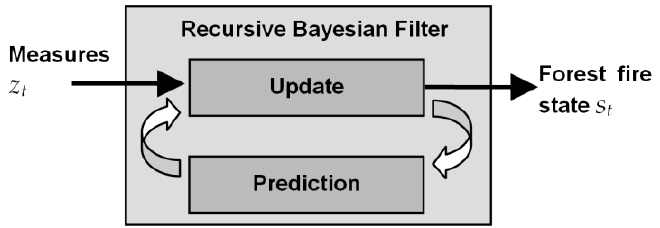
Figure 8. Diagram of the Recursive Bayesian Filter used.